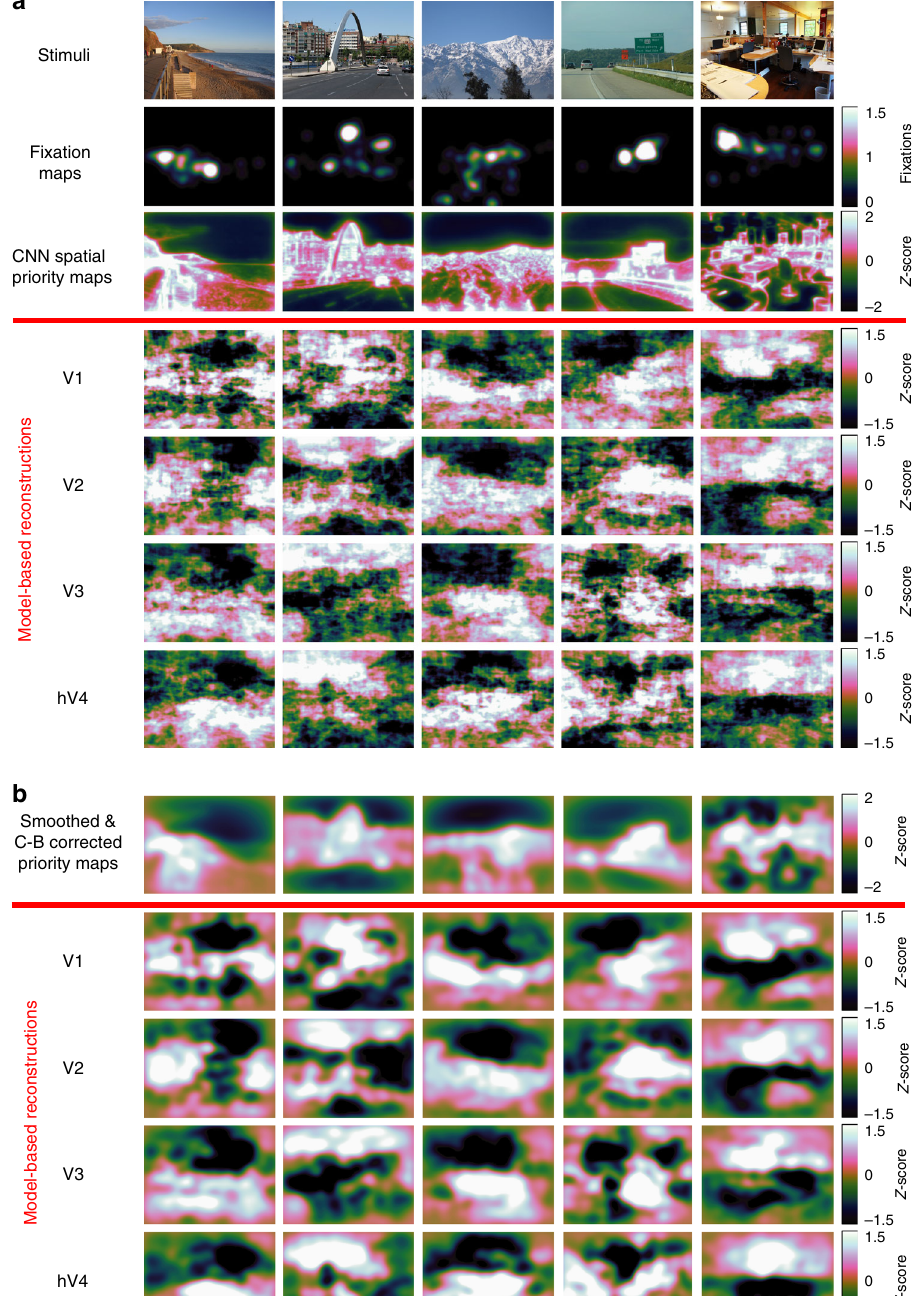
Fig. 5 Model-based reconstructions from early-visual ROIs. a Example stimuli, fi xation maps, computational spatial priority maps and model-based priority map reconstructions from early-visual ROIs. Fixation maps were averaged across all participants in the external validation data set ( n = 22), and model- based reconstructions were averaged across all participants in the main experiment ( n = 11). b Example computational priority maps with smoothing and center-bias correction and model-based reconstructions with smoothing and center-bias correction. Model-based reconstructions were averaged across all participants in the main experiment ( n =